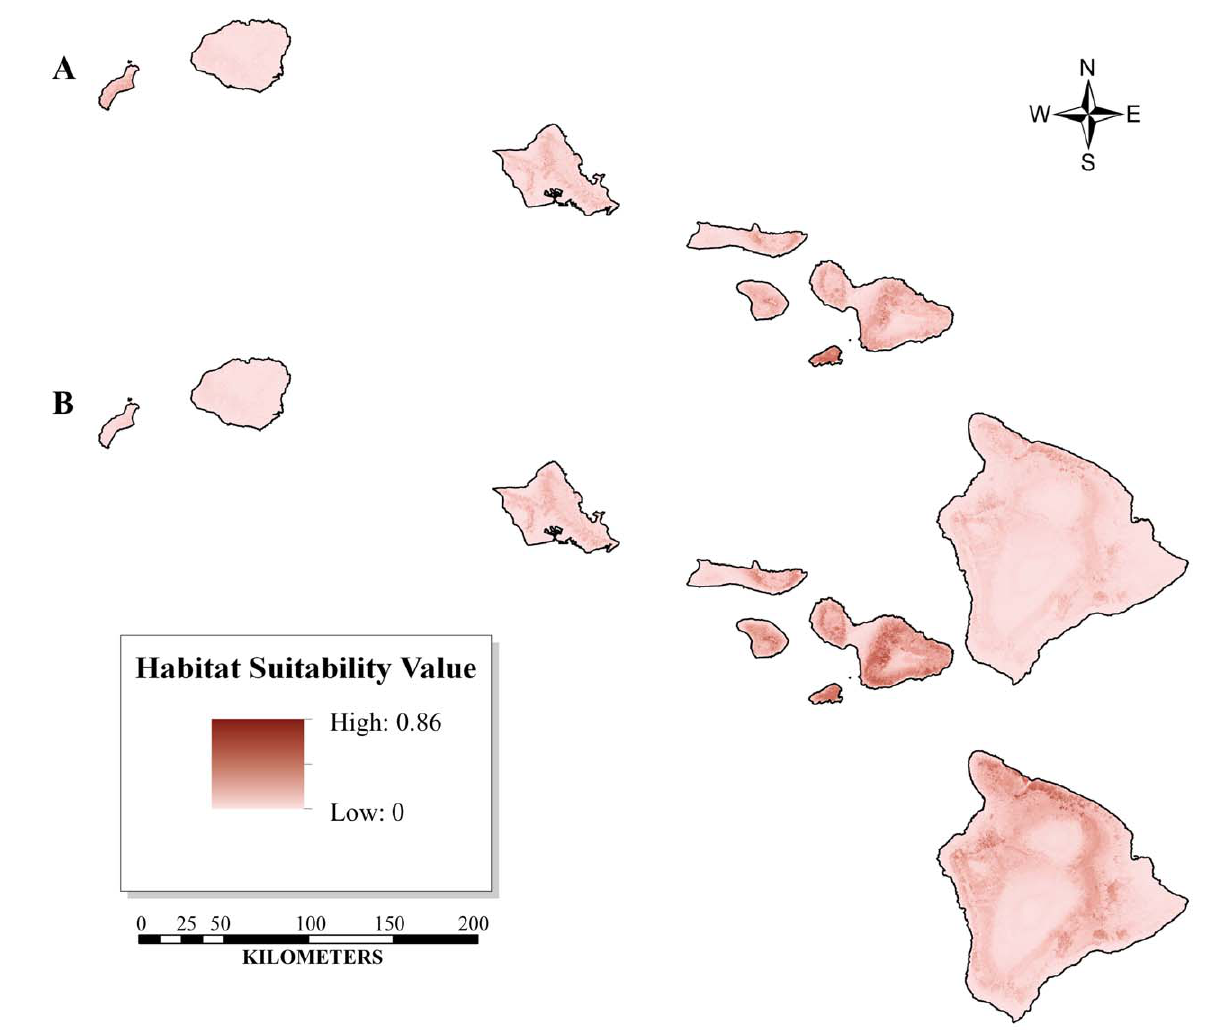
Figure 2. The Ecological Niche Models (ENM) defined in Maxent showing the distribution of O.continuatialis as collected from 2004 to 2010 and projected onto a set of biotic and abiotic variables. The figure shows the current ENM (A) along with that of the ENM projected into 2050 (B). The 2050 GFDL 2.1 climate change model was used to derive projected future climate variables. As compared to the current distribution (A) the 2050 projected distribution (B) shows an expansion of suitable habitat area (see Table 4).